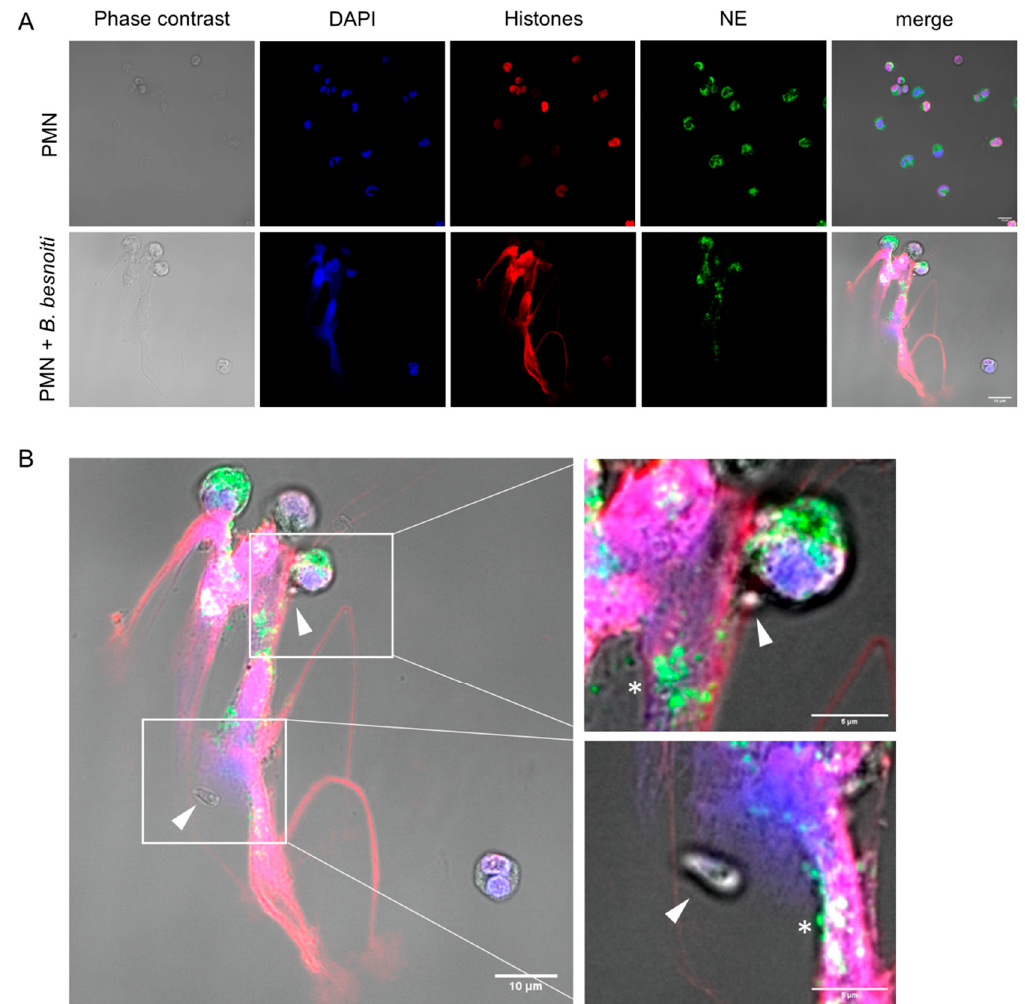
Figure 1. B. besnoiti tachyzoites induce neutrophil extracellular traps (NETs). 2 × 10 5 bovine polymorphonuclear neutrophils (PMN) were confronted with plain medium (control) or 8 × 10 5 B. besnoiti tachyzoites (1:4 ratio) for 3 h at 37 °C and 5% CO 2 . Samples were fixed and immune-stained for neutrophil elastase (green) and histones (red). The coverslips were mounted in mounting media containing 4 ′ ,6-Diamidine-2 ′ -phenylindole DAPI to stain DNA (blue). Representative image of NETs in response to B. besnoiti tachyzoites is shown in ( A ). In ( B ) a zoom shows the detail of NETs trapping B. besnoiti tachyzoites (white triangle). In addition, the dotted distribution of neutrophil elastase in NETs is observed (white asterisk).